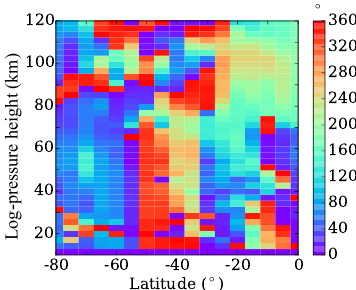
Figure 10. Run3–Run1 phase differences of zonal GW flux